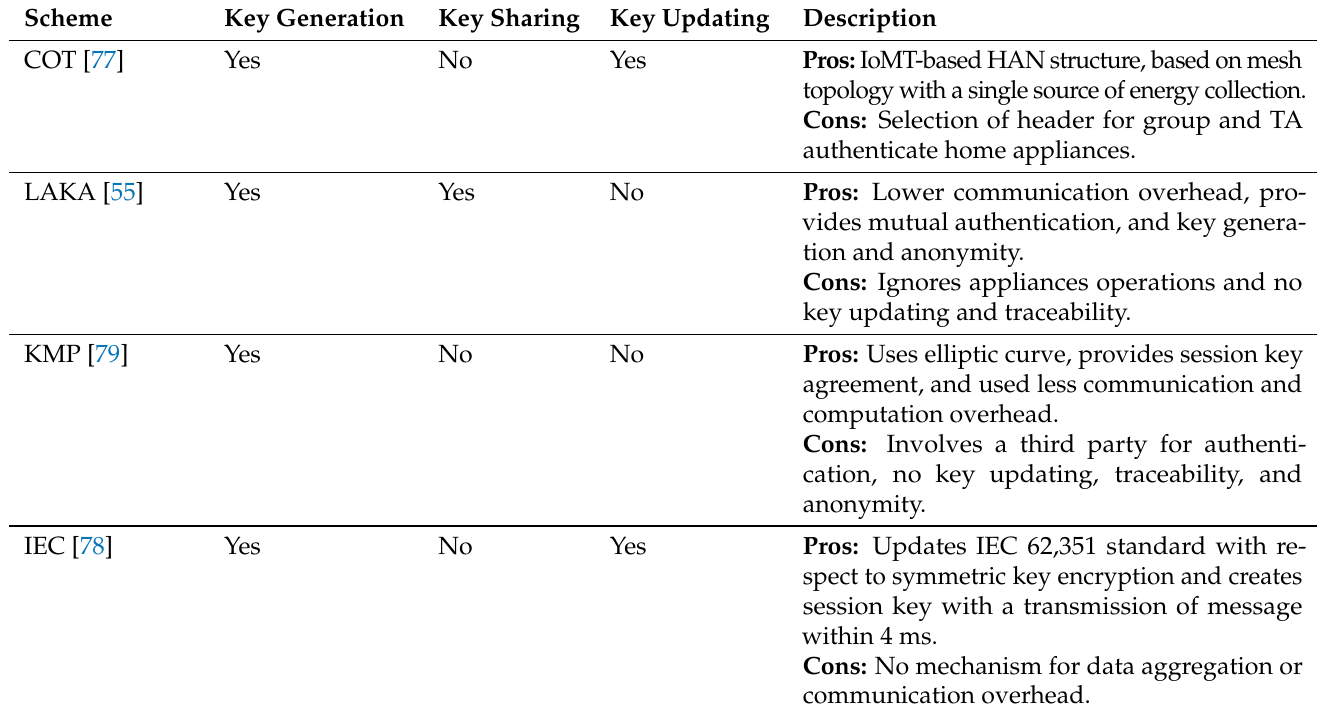
Table 4. Comparative analysis of key management